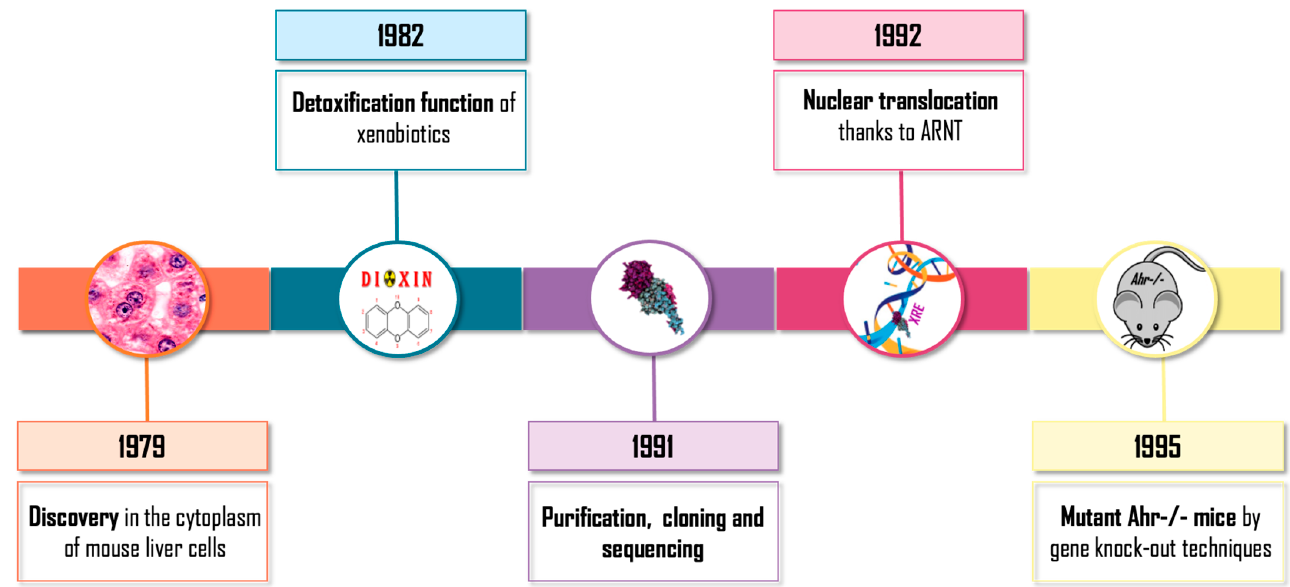
Figure 1. Early timeline of AHR research.